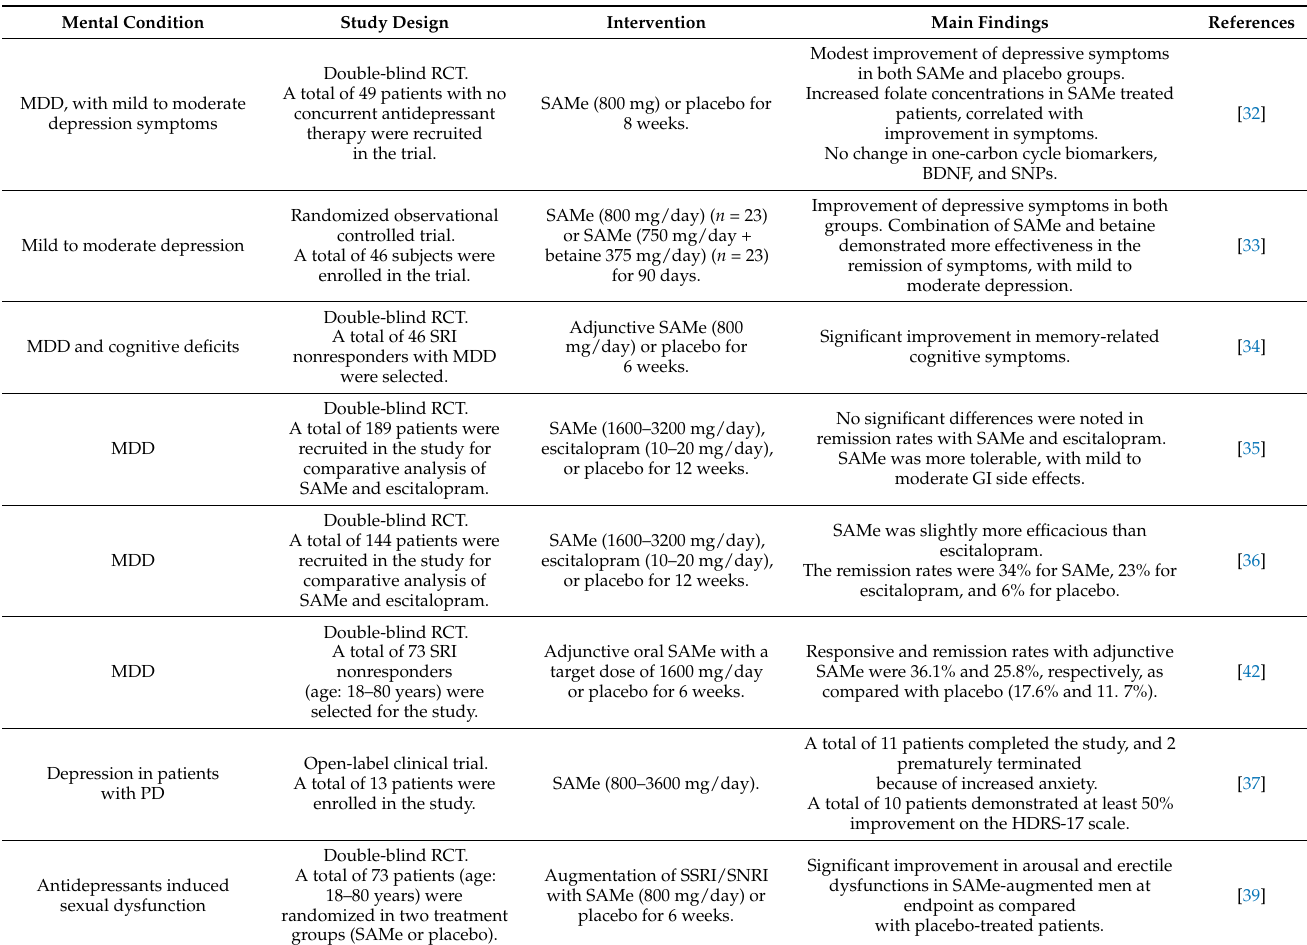
Table 1. Efficacy of SAMe in depression, as evidenced from clinical